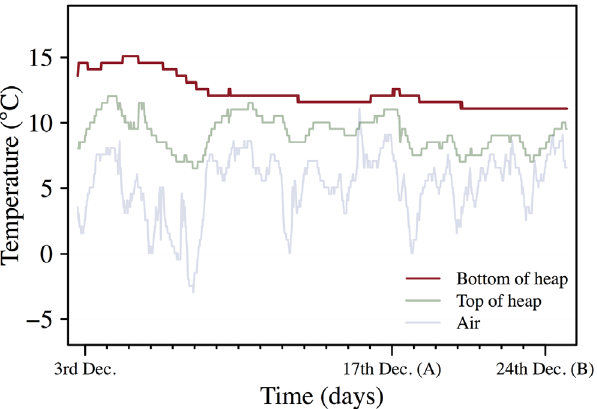
Fig 1. Field site temperatures. Air temperature 1 m above the heap (air), temperature 10 cm below the surface of the heap (top of heap) and temperature 40 cm below the surface of the heap (bottom of heap) at the field collection site. The temperatures were logged every half hour. (A) Cold and heat tolerance were assessed; (B) Egg-to-adult viability experiment was